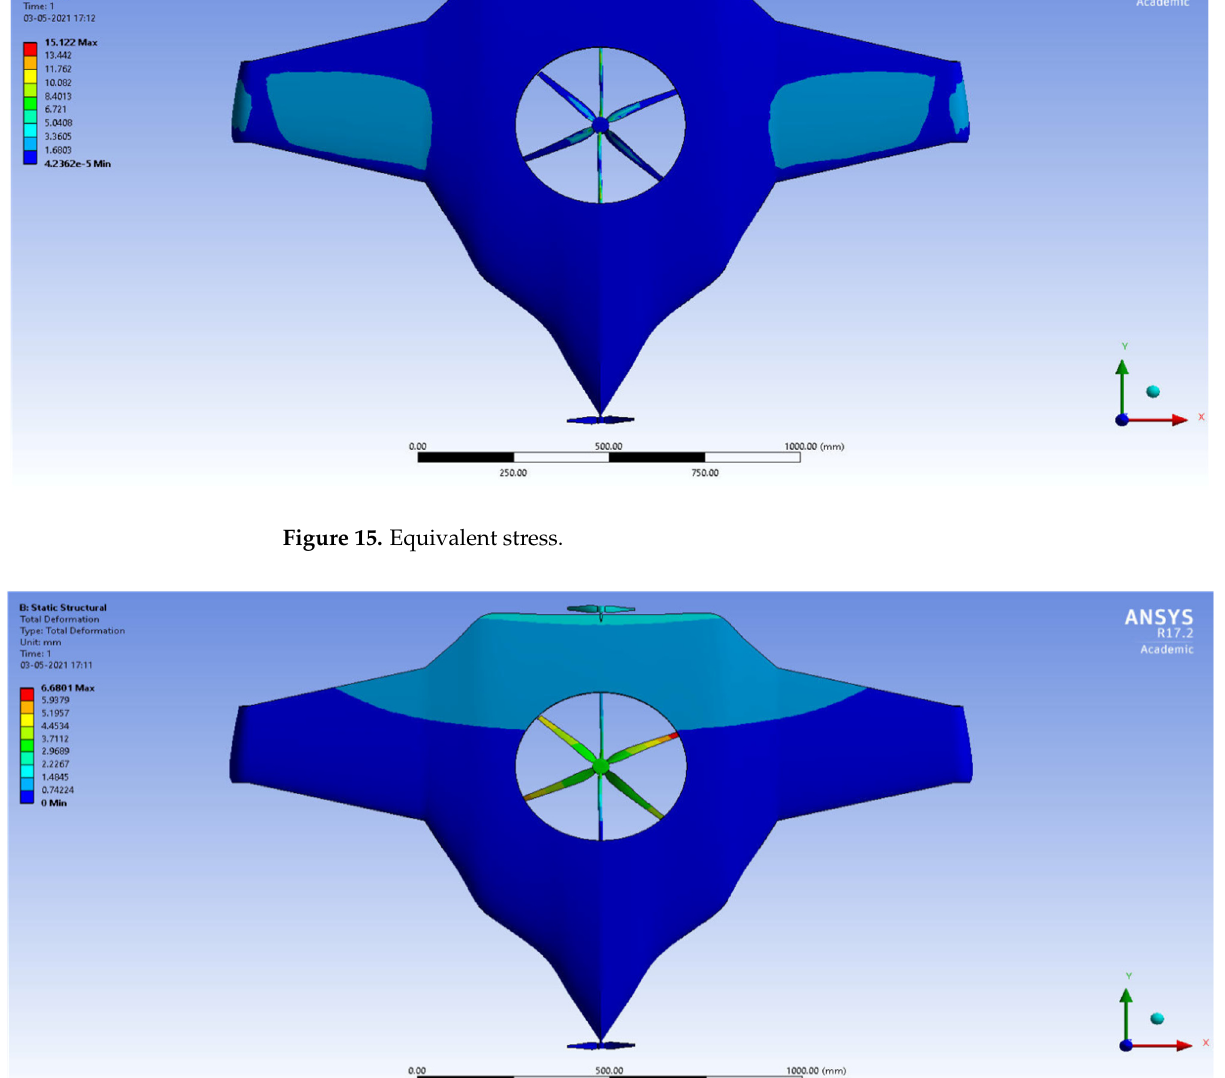
Table 3. Comparative structural outcomes under forward speed manoeuvring.